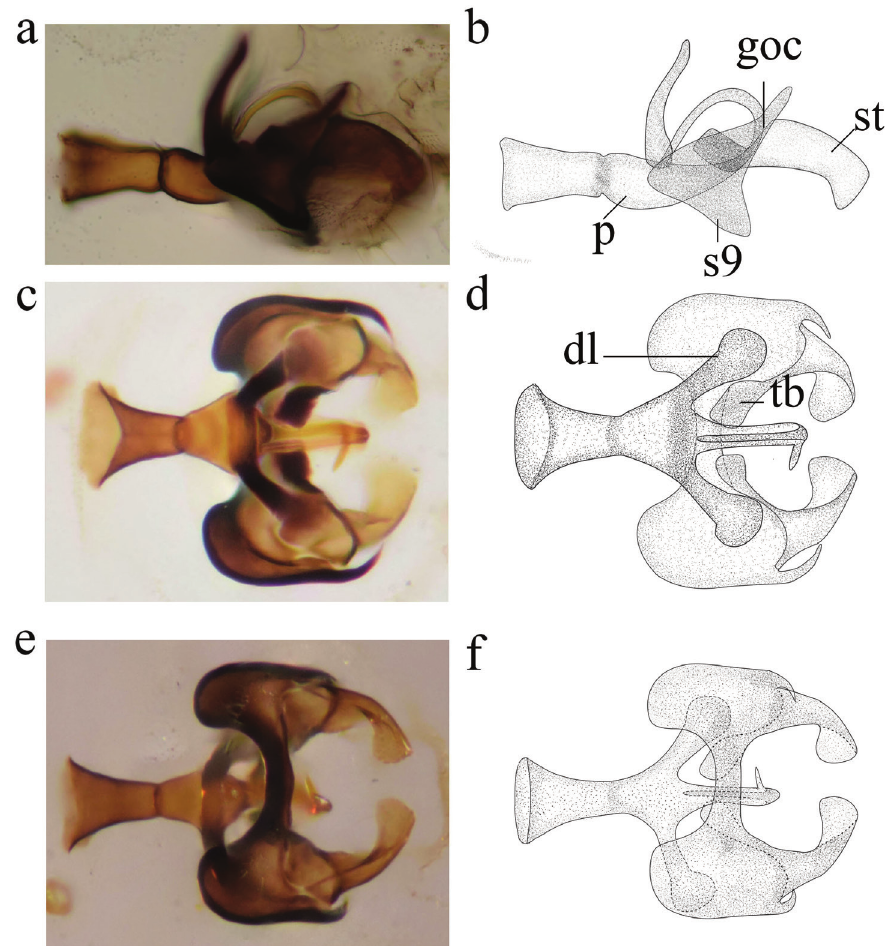
Figure 2. Heteroconis orbicularis sp. nov., holotype male, genitalia a, b lateral view c, d dorsal view e ven- tral view f penis, dorsal view. p, penis; s9, ninth sternite; tb, transverse band; goc, gonocoxite; dl, dorso- lateral projection of penis; st,